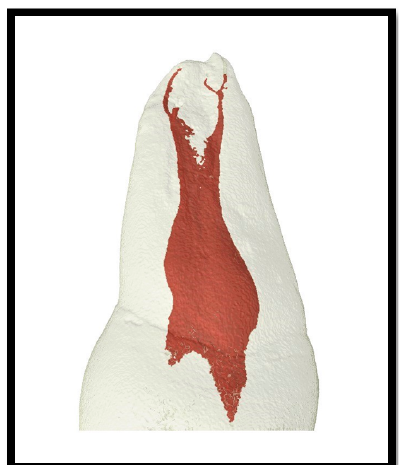
Figure 8. Micro-CT image showing the additional canal configuration (2-3).